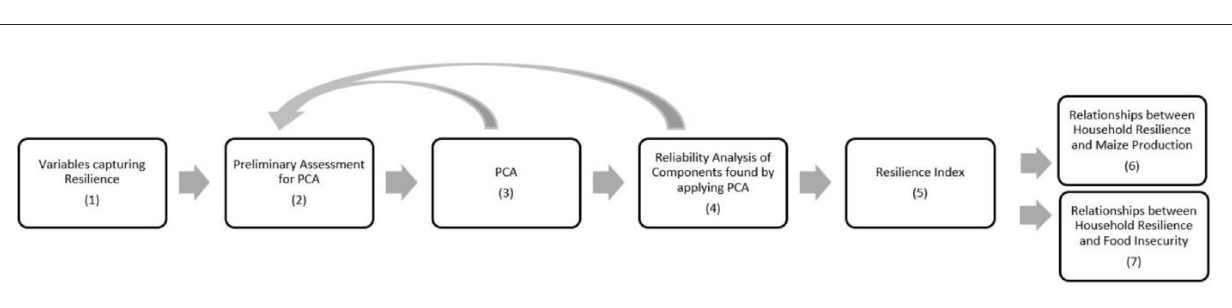
FIGURE3 Analysis steps applied for assessing livelihood